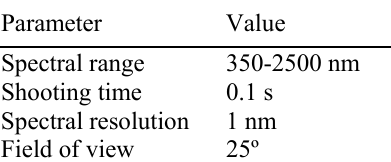
Table 3. Technical specifications of the FieldSpec 3 ADS Spectroradiometer.